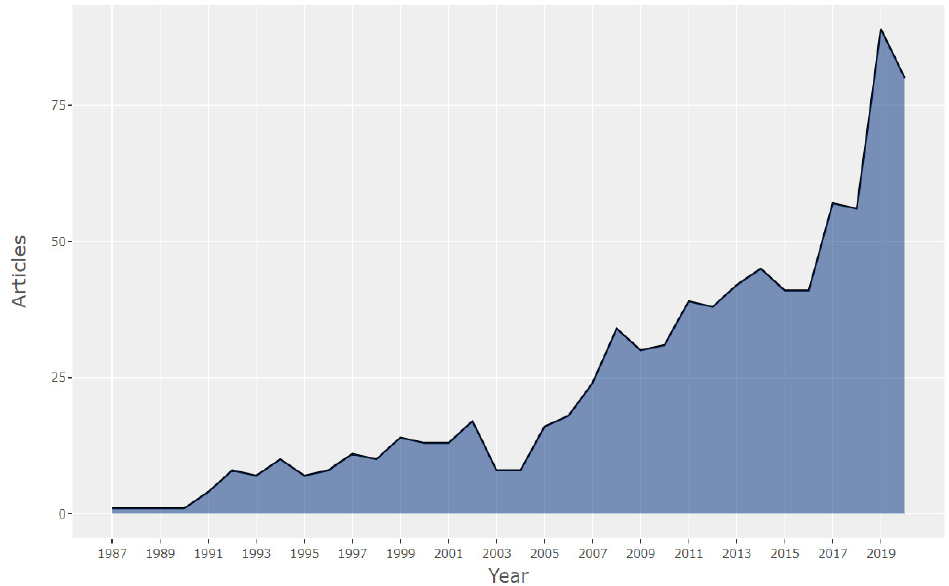
Figure 1. Annual scientific production.